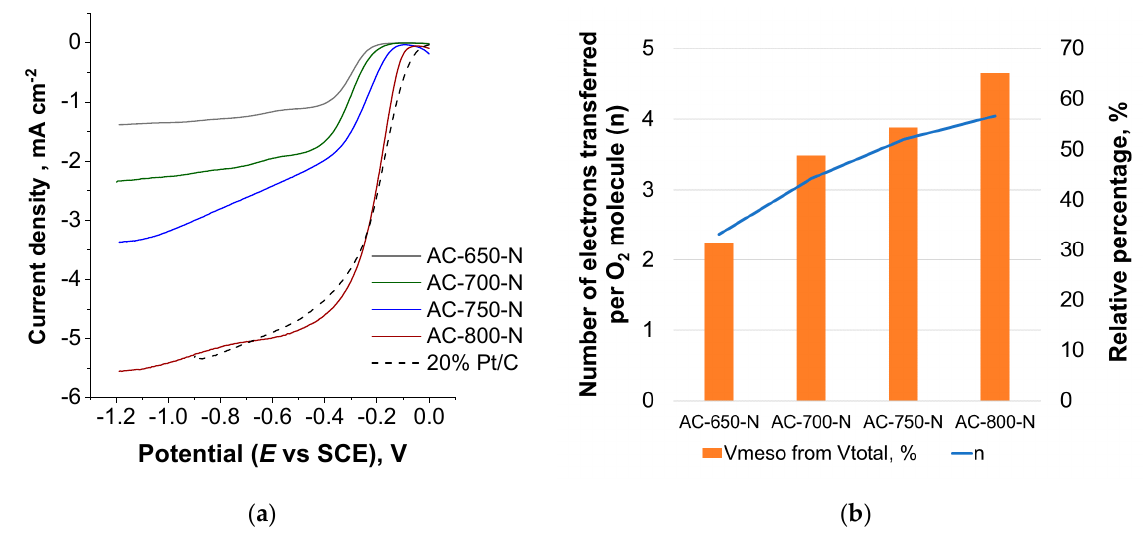
Figure 5. RDE polarization curves of GC electrodes modified with wood-based, nitrogen-doped activated carbons synthe- sized at various temperatures and commercial 20% Pt/C in O 2 saturated 0.1 M KOH ( ν = 10 mV s − 1 , ω = 1900 rpm) ( a ). Changes in the number of transferred electrons, n (per O 2 molecule), depending on the mesopore volume ratio ( b ).